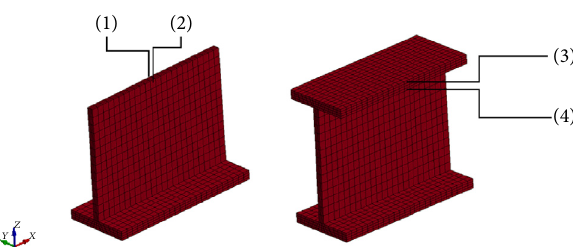
Figure 26: Symmetrical elements of web and flange.